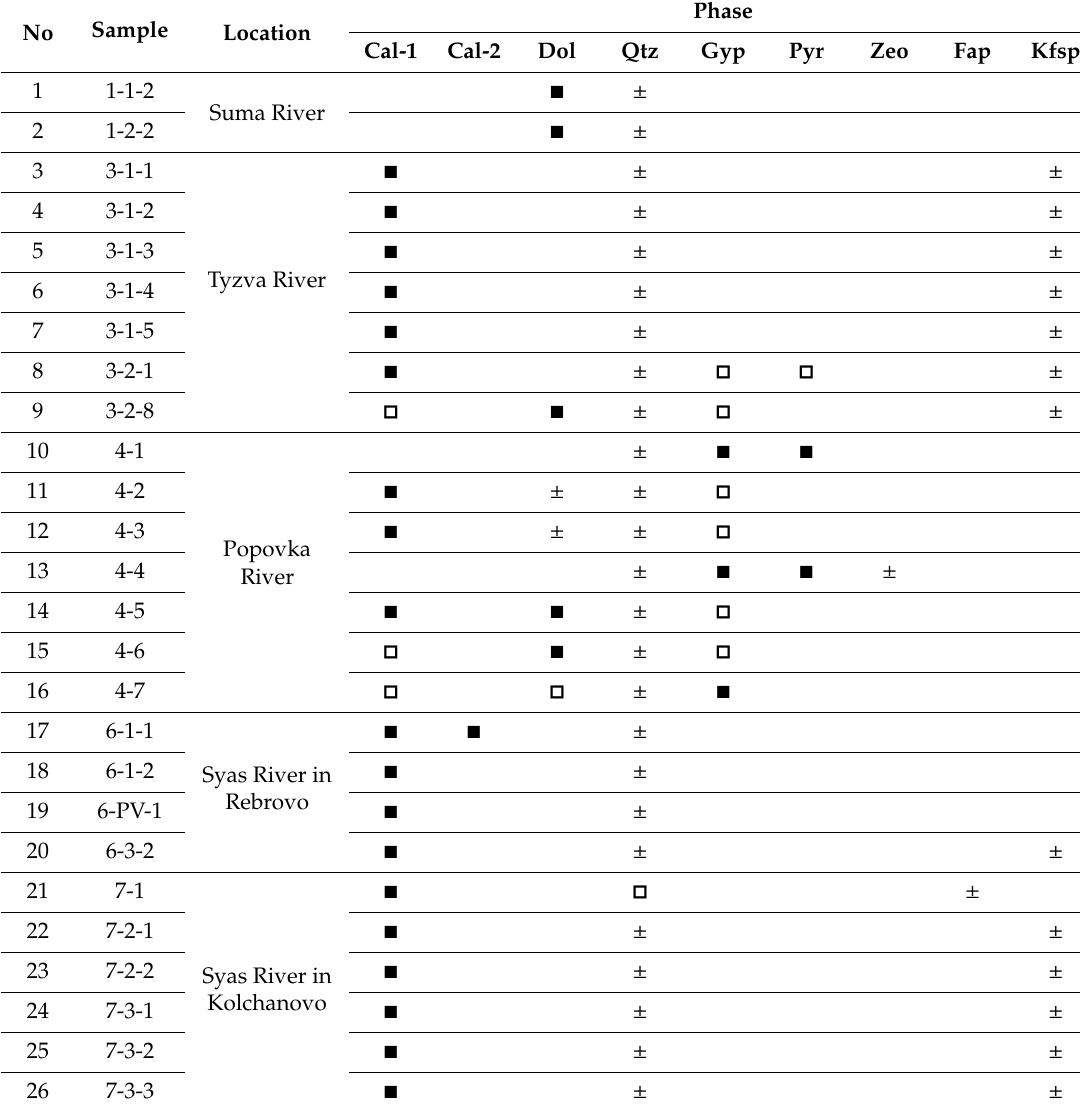
Table 1. Mineralogy of the studied anthraconite samples (data obtained by X-ray di ff raction).